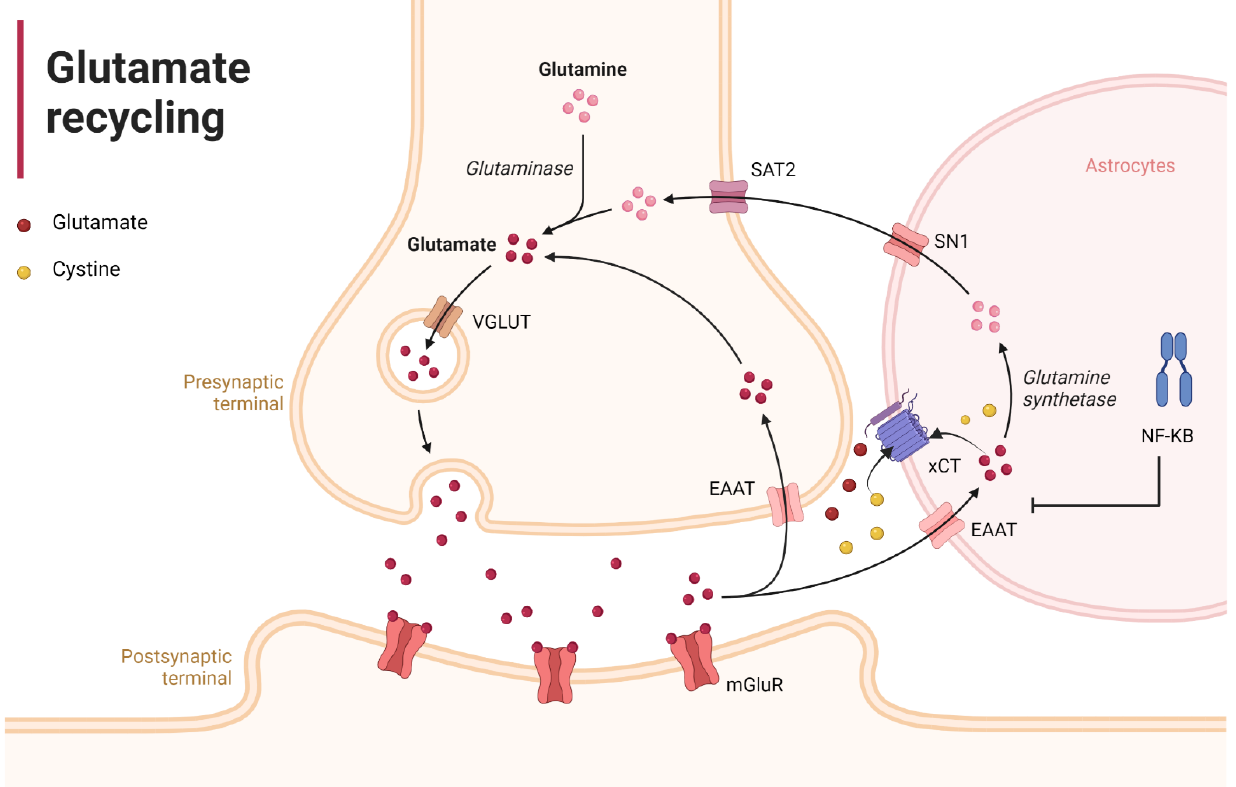
Figure 2. Glutamate recycling: Glutamate (red-filled circles) is quickly cleared from the extracellular space. The EAAT2 in astrocytes is responsible for 90% of the reuptake, and its expression is regulated by NF- κ B [54]. Glutamate is first converted by glutamine synthetase and then transported back to the extracellular space by the System N (SN1) glutamine transporter. Glutamine is then transported into neurons by the System A transporter (SAT2) and, subsequently, converted back to glutamate by glutaminase to complete the cycle [56]. In addition, astrocytes can release glutamate through the cystine/glutamate antiporter (xCT). This antiporter takes up extracellular cystine and releases intracellular glutamate [57]. Figure was created with the BioRender software.